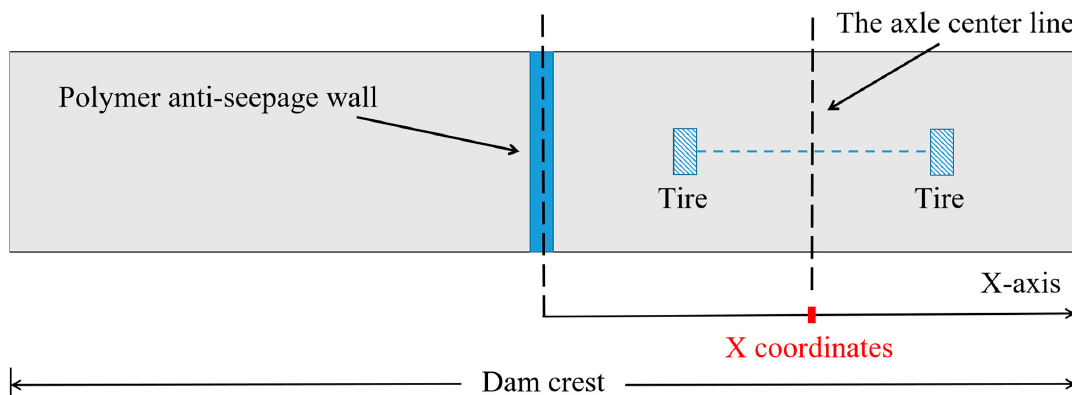
Figure 4. Contact surface between tire and ground.